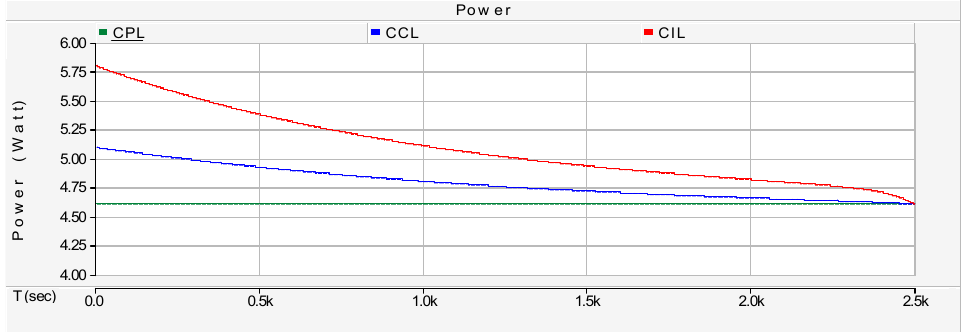
Figure 19. Power profile to reach point of same output ‐ power in all modes.